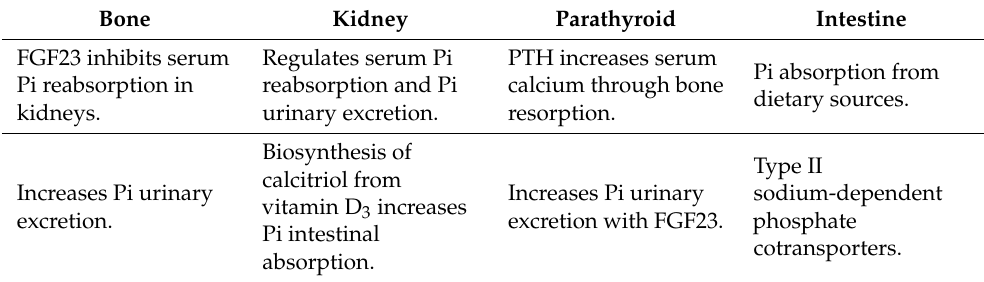
Table 1. Endocrine Regulation of Serum Pi through the Bone–Kidney–Parathyroid–Intestine